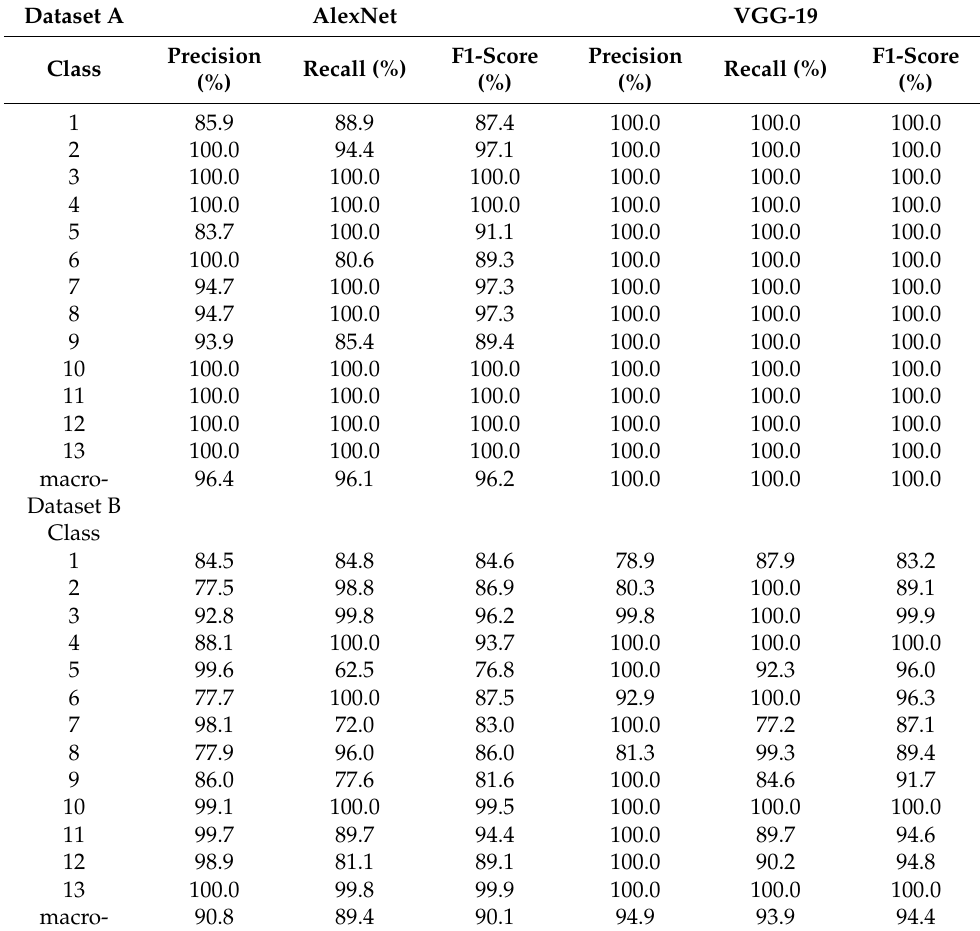
Table 3. Precision, recall, and F1-score of AlexNet- and VGG-19-based models on dataset A and dataset